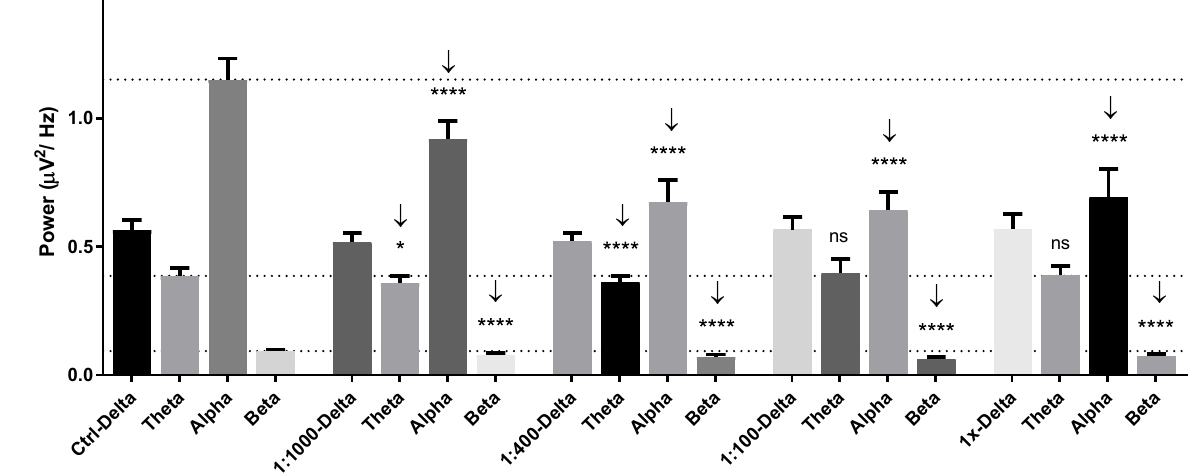
Figure 1. Power spectral analysis of human brainwaves characterized by frequencies consisting of delta, theta, alpha, and beta wave powers in control, 1:1000 dilution, 1:400 dilution, 1:100 dilution, and undiluted groups of Litsea cubeba oil. Not significant (ns), *, and **** represent no statistical differences, p < 0.05, and p < 0.0001, respectively.